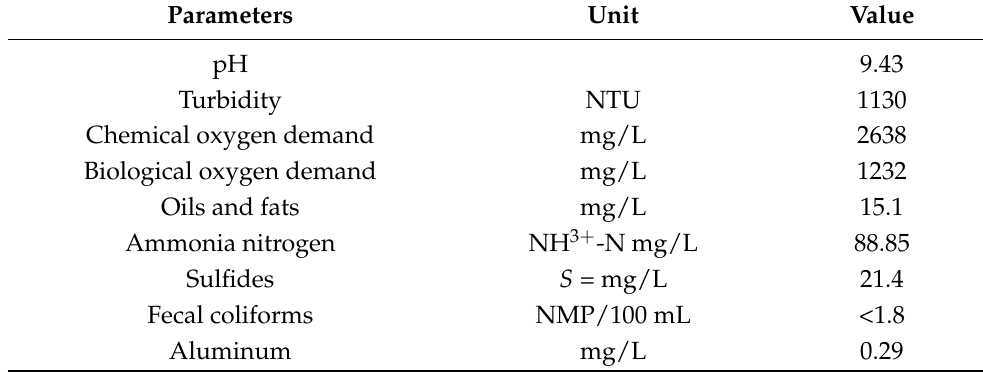
Table 1. Some of the physicochemical characteristics of the wastewater of the riparian